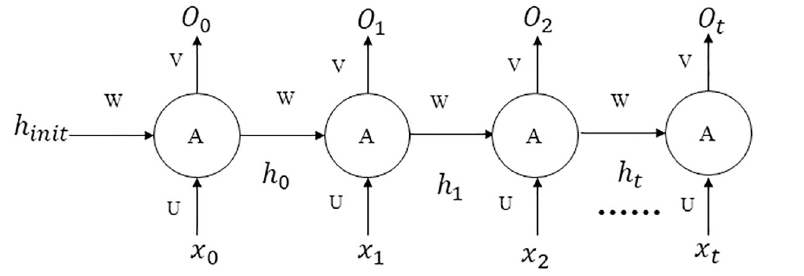
Fig 1. The unfolding diagram of the forward propagation of the